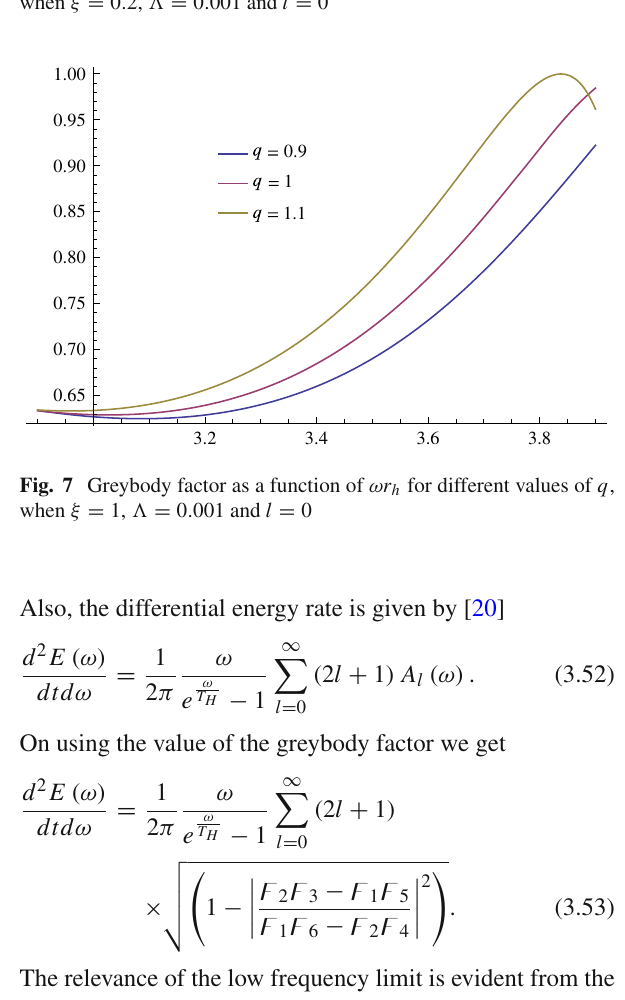
Fig. 6 Greybody factor as a function of ω r h for different values of q , when ξ = 0 . 2, (cid:5) = 0 . 001 and l = 0